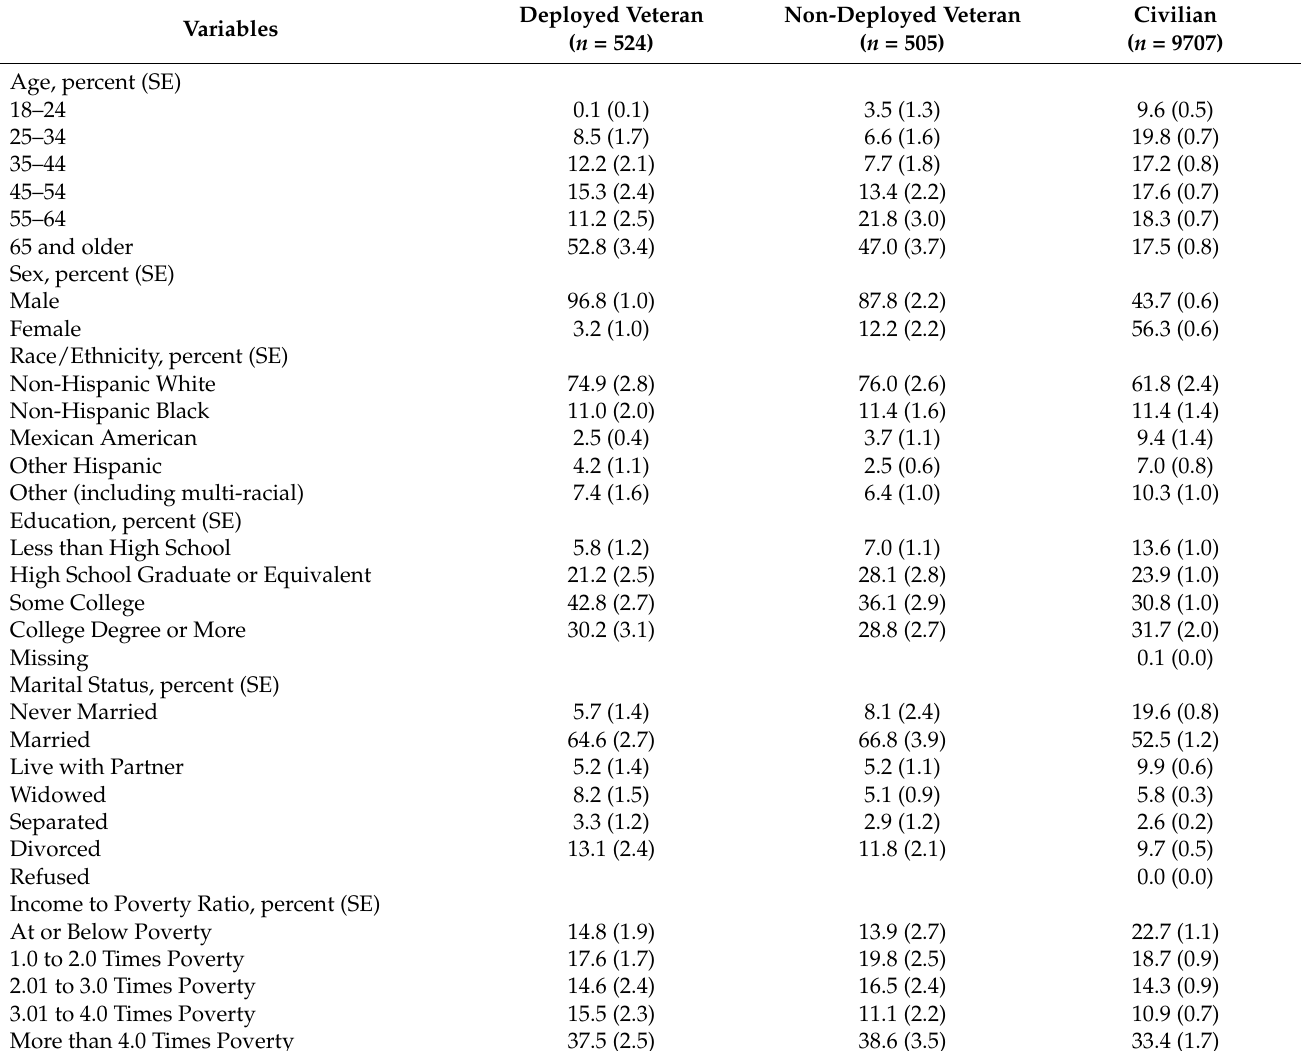
Table 1. Weighted demographic and socioeconomic characteristics ( n =